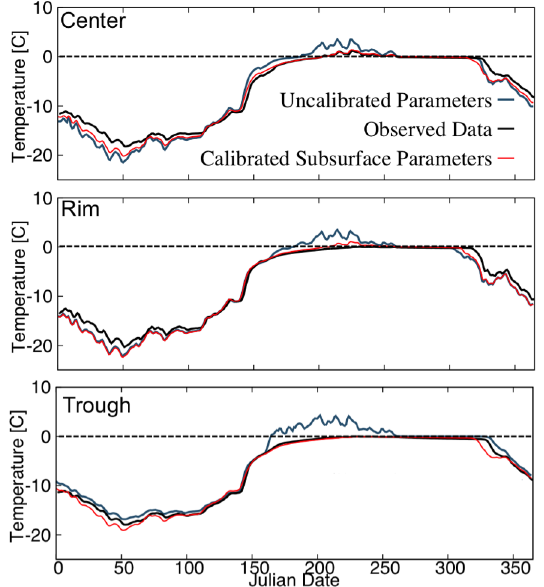
Figure 7. The subsurface un-calibrated and calibrated temperature time series is compared to measured soil temperature time series to showcase the improvement from the calibration process at 40cm depth for the center, trough and rim. The initial un-calibrated param- eters were selected from the literature search described in Sect. 2.4 and Appendix C. Calibration fit to observation varies from the three columns, but shows marked improvement from initial un-calibrated time series and are most accurate for all three during the summer at depth where active layer thickness is